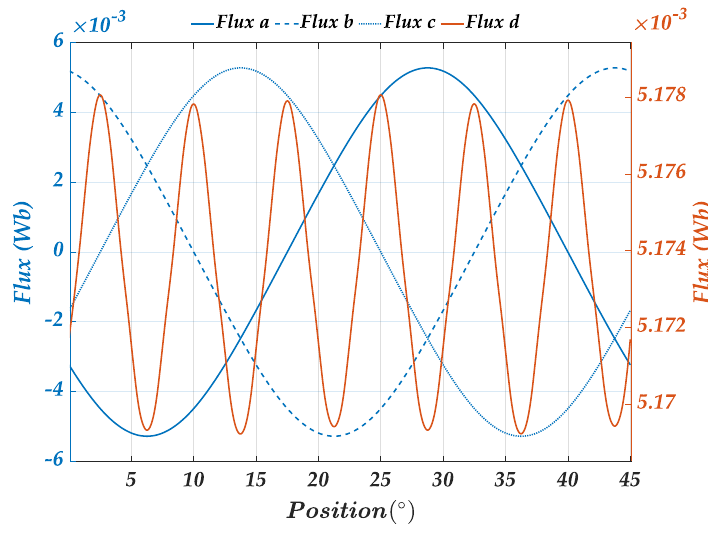
Figure 4. Magnetic fluxes during a full electrical